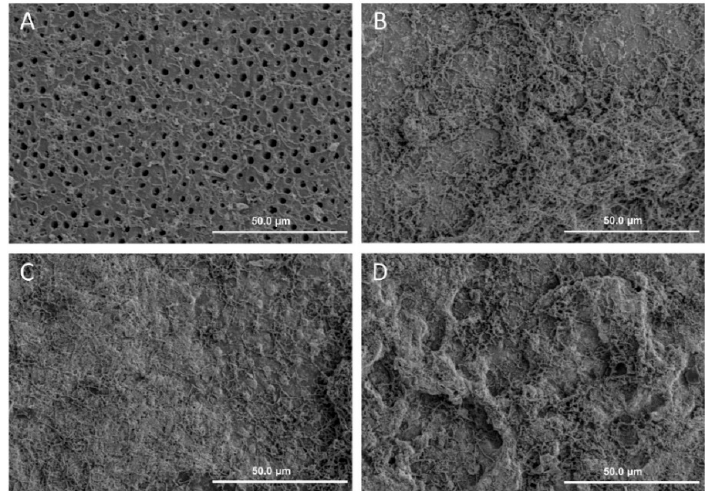
Figure 4. SEM images of biofilm of different groups on dentine surface after 48 h (×1000). ( A ) PDA + PEG; ( B ) PEG; ( C ) PDA; ( D ) Water (PDA: polydopamine, PEG: polyethylene glycol).